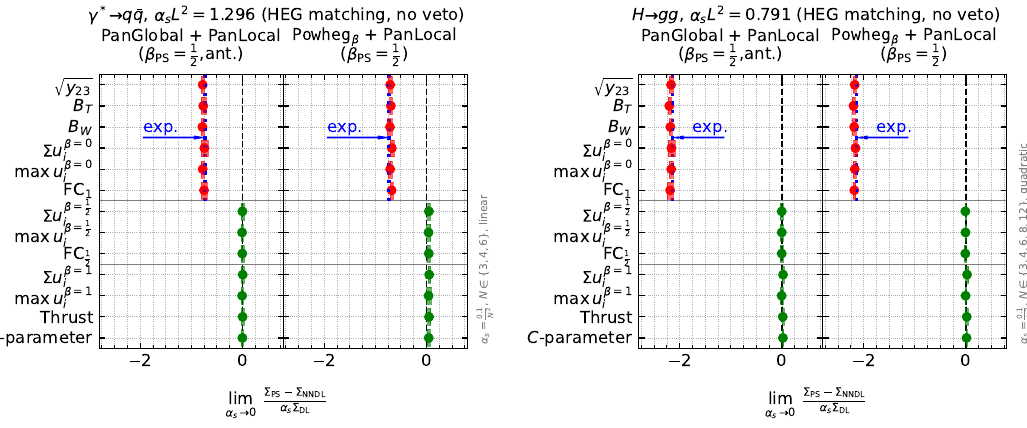
Figure 7. Results of NNDL accuracy tests for two combinations of HEG and shower whose contours do not match in the hard-collinear region, all with β with the POWHEG scheme, but the vetoing procedure given in section 3.3 is not applied, in order to highlight the NNDL discrepancy expected for observables with β from eqs. (3.9)–(3.10) is shown in dotted blue (and marked by the blue arrow labelled